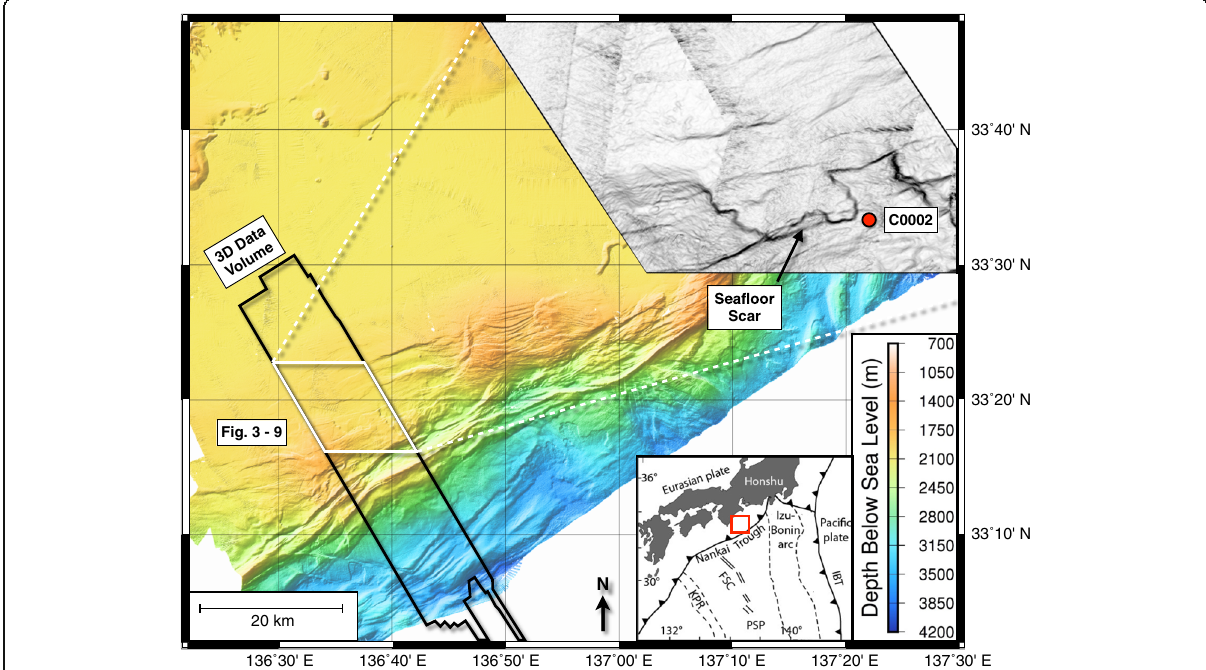
Fig. 1 Study area. High-resolution bathymetry of the Kumano Basin acquired by R/V Sonne during Cruise SO251 in 2016 (Strasser et al. 2017). The trapezoidal inset shows a slope gradient map of a prominent seafloor scar from Lackey et al. (2018) and the location of IODP drill site